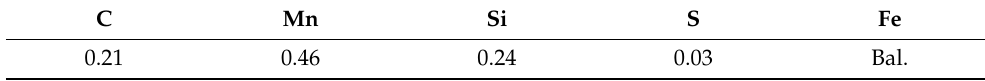
Table 1. Chemical compositions of carbon steel (wt.%).